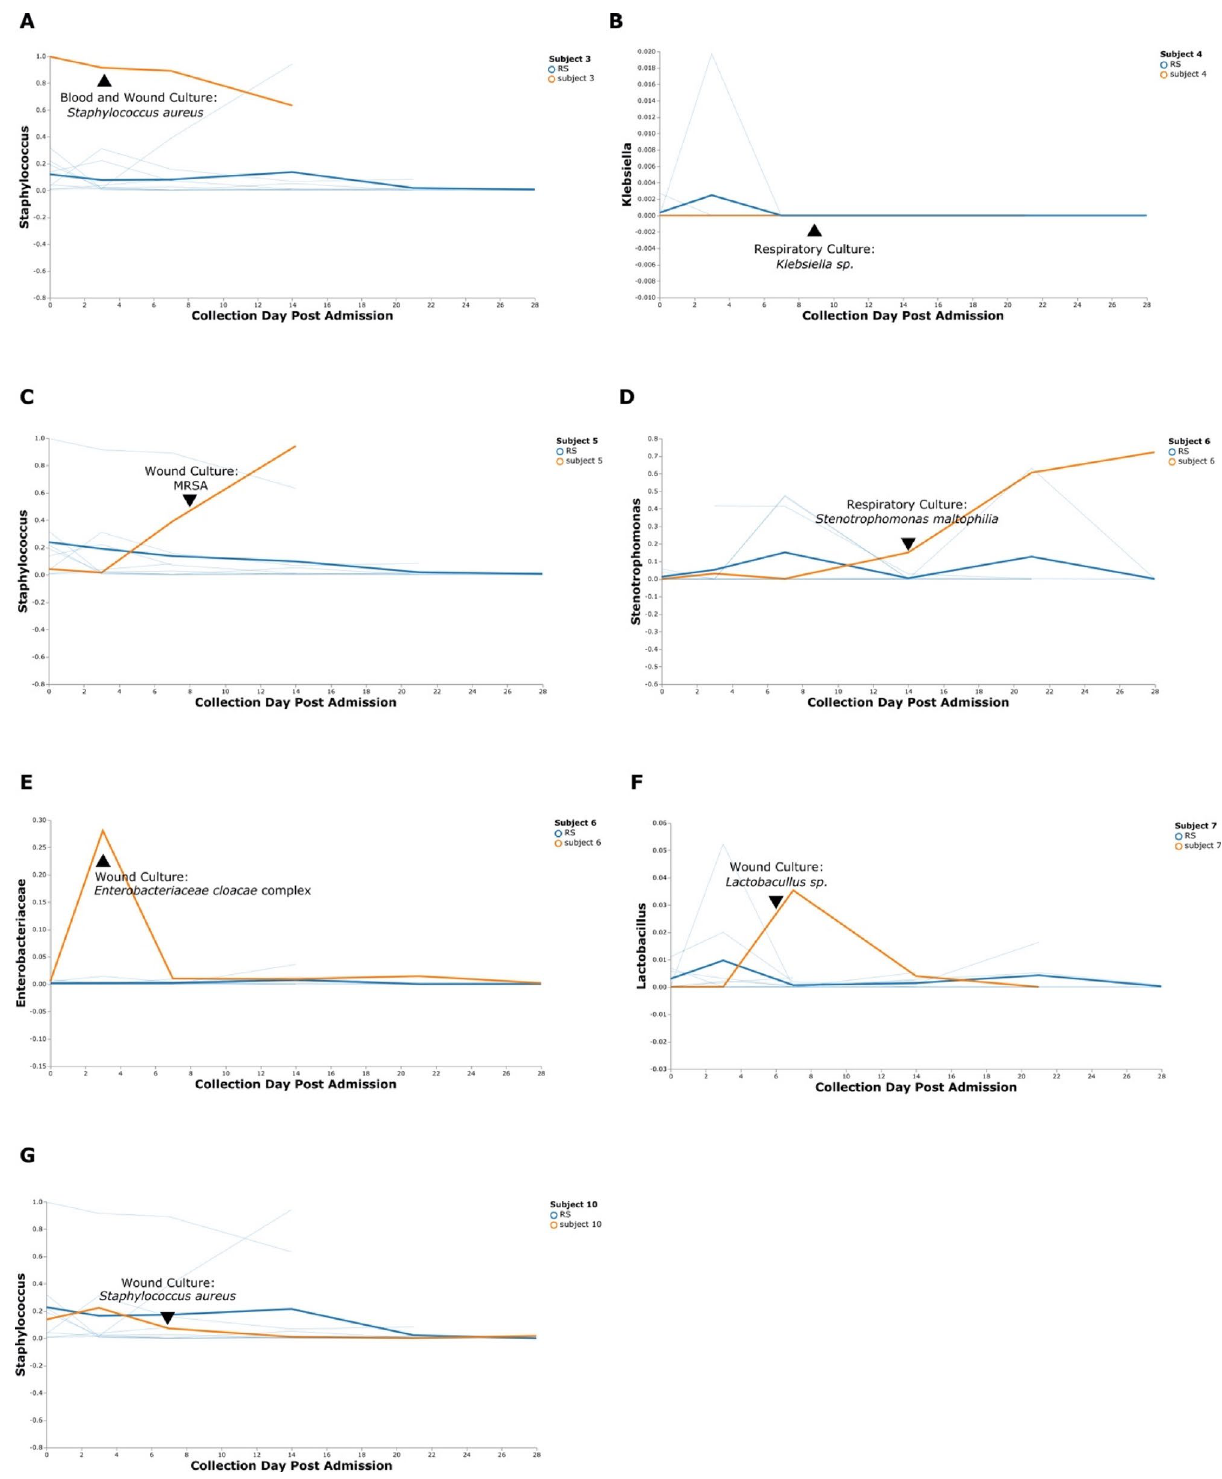
Figure 8. Longitudinal Visualization of Culture Isolated Bacteria from the Burn Wound. ( A – G ) Volatility plots display in orange the longitudinal change relative abundance of a bacterial ASV from the order or genus that was identified by culture for individual burn subjects. The thick blue line depicts the average of the relative abundance of the same ASV from the remaining subjects. Thin blue lines are representative of individual relative abundances of the ASV from each of the remaining subjects. A black triangle indicates the day a culture was collected for a clinically suspected infection for each subject while on the study. Subjects 3, 4, 5, 7, and 10 had one culture and Subject 6 had two. MRSA , methicillin resistant Staphylococcus aureus ; RS , remaining subjects. This figure was generated using the software Inkscape and visualizations generated by